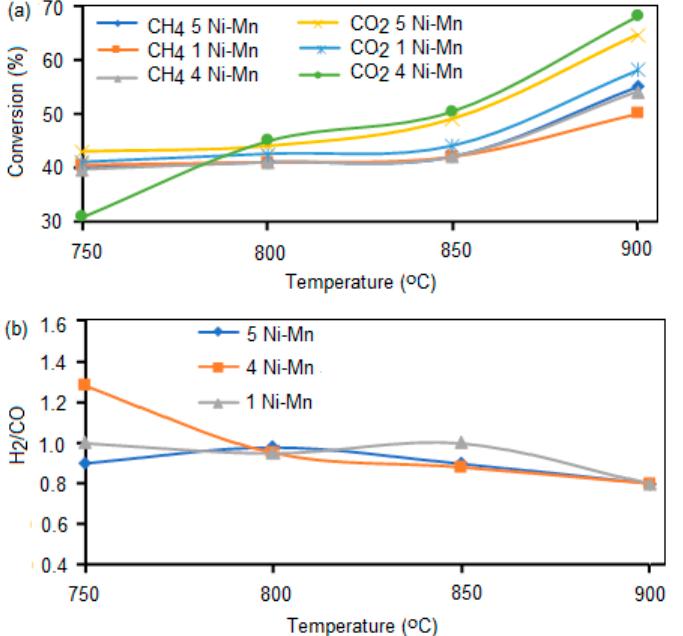
Figure 8. Influence of reaction temperature and catalyst composition on the methane and carbon dioxide conversion and product H 2 /CO ratio (flow rate 860 h − 1 ).